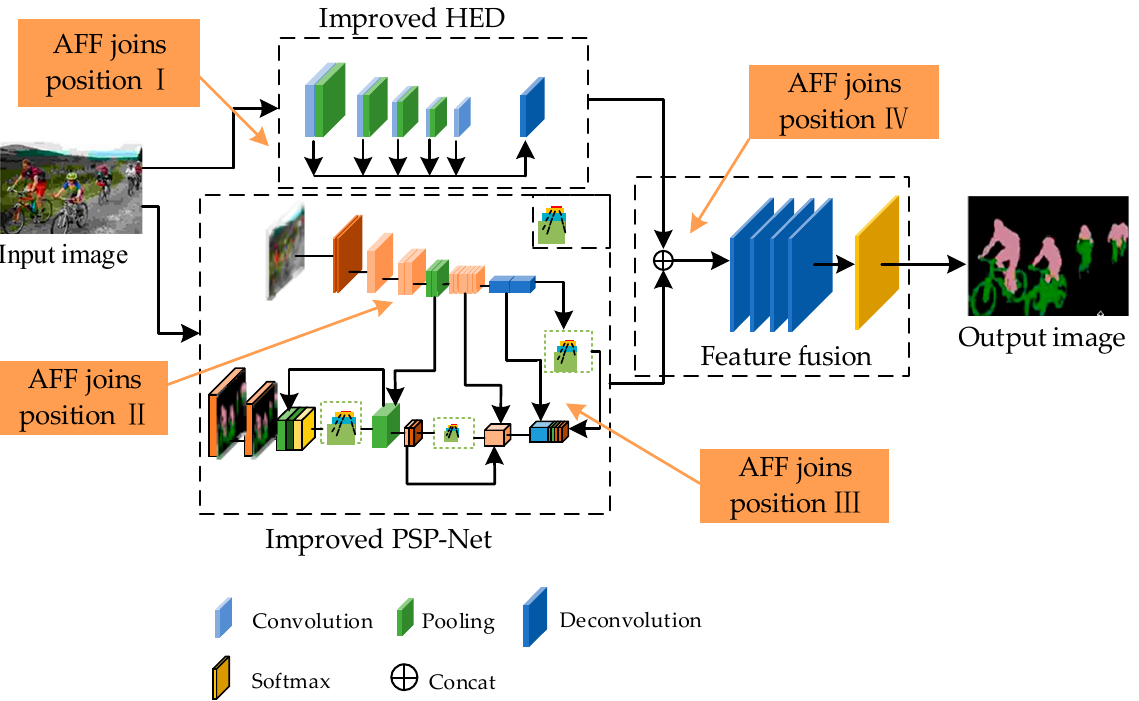
Figure 15. A semantic segmentation network architecture combining edge detection and AFF atten- tion mechanism.